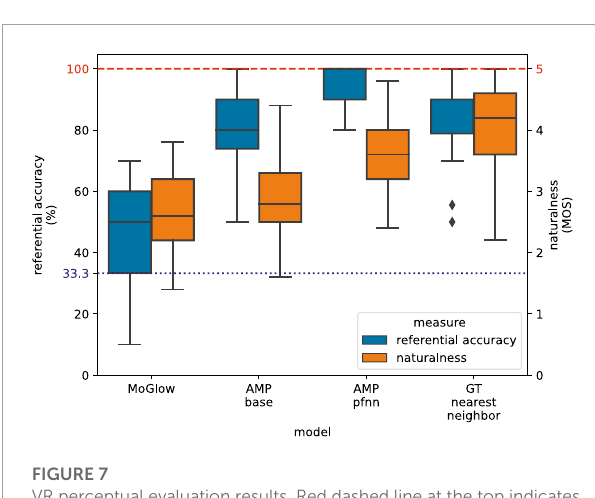
FIGURE 7 VR perceptual evaluation results. Red dashed line at the top indicates maximum possible values for referential accuracy and naturalness MOS. The blue dotted line at accuracy 33.3% corresponds to uniform guessing among 3 possible choices in the referential accuracy evaluation. All between-model differences in the two measures are significant (Wilcoxon signed-rank test with Holm-Bonferroni correction at α = 0 . 01), except for referential accuracy between AMP-base and